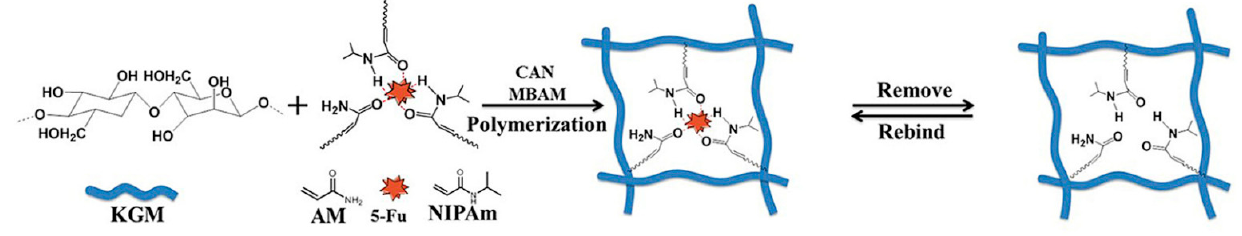
Figure 13. Schematic procedure of synthesis of 5-fluorouracil thermo- responsive MIP reported by Ann et al. Reprinted [69], Copyright (2022), with permission from Elsevier [or applicable society copyright owner].